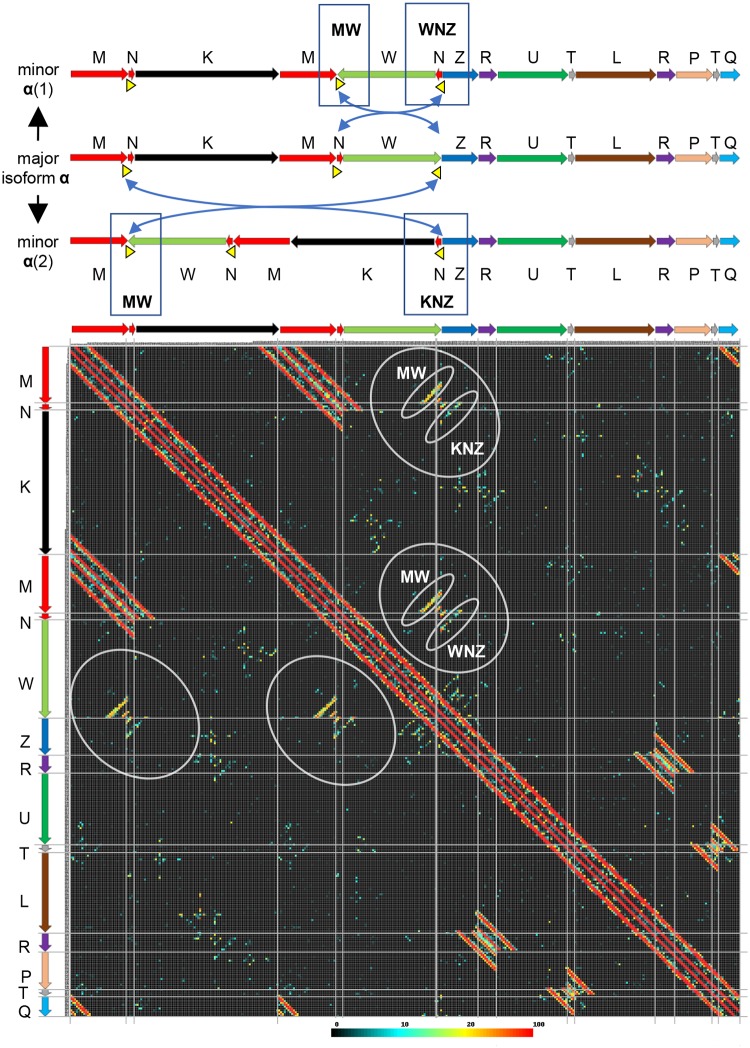
Detection of minor isoforms using Illumina mate pair data.Above, schematic illustrations of the transition between major isoform α and two minor isoforms through recombination at repeat X-01b (yellow triangles and blue arrows). Below, high-resolution-Illumina-mate-pair plot showing sequence connections (indicated by gray ovals) that are expected for the minor isoforms shown above. Mate-pair library sizes were 2.5 and 10 kb. The major mitochondrial isoform of L. sativa includes the following order of basic units: M-N-K-M-N-W-Z. There is a medium size repeat X-01b of length ~500 bp (yellow triangle) at the N and W termini that can cause two distinct recombination events as shown on the right side of the figure. Upon X-01b recombination, two new isoforms have three distinct junctions M-W (common for both), W-N-Z, and K-N-Z (specific for each isoform). A long distance plot of mate-pair libraries clearly demonstrated the existence of both isoforms and all three junctions. Ovals highlight the diagonals of long distance interactions that were evidence of the existence of minor isoforms for the L. sativa mitochondrial genome. Similar patterns were detected using L. serriola mate pair libraries (Fig 4B and S5C Fig). The color gradient displayed below panels reflects the total number of read-pairs (out of a total of 320,000) in each 2-dimensional-1-kb bin and applies to all panels.